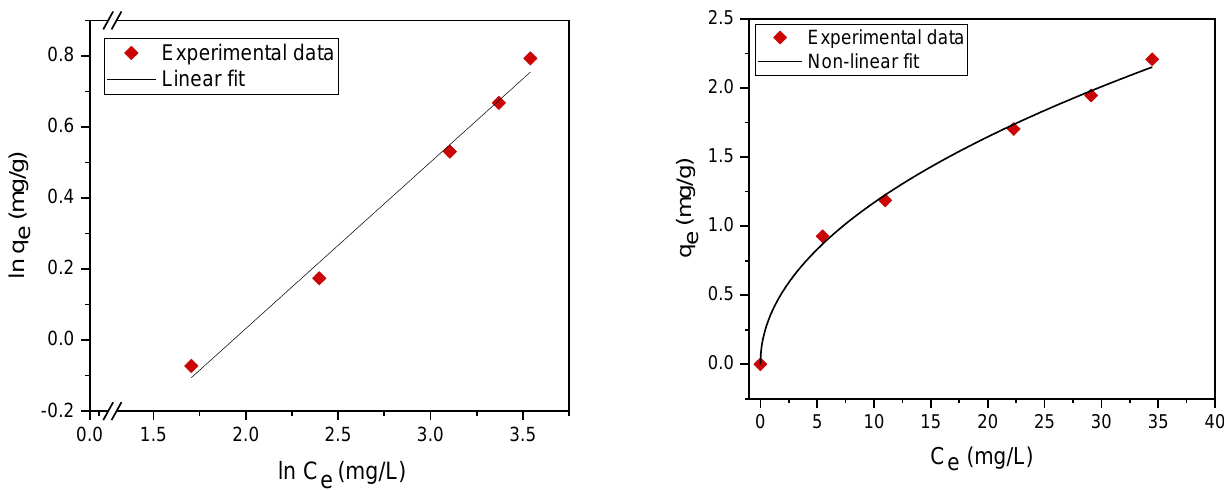
Figure 8. Freundlich adsorption isotherm nonlinear fit ( right ) and linear fit ( left ). Table 4. Langmuir and Freundlich isotherm parameters.